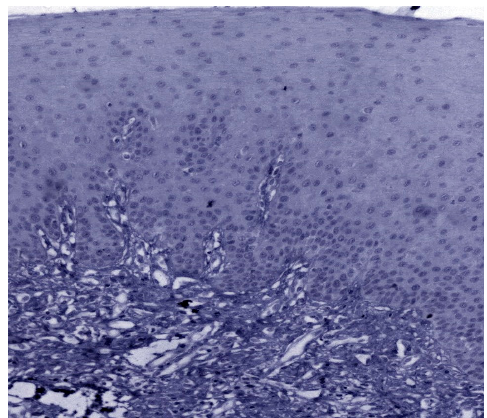
Figure 10. IHC for HSP 70 in normal samples (under 20× magnification).